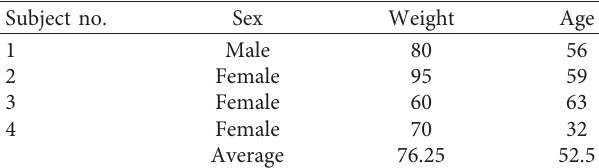
Table 3: The physical data of selected volunteers. Subject no.